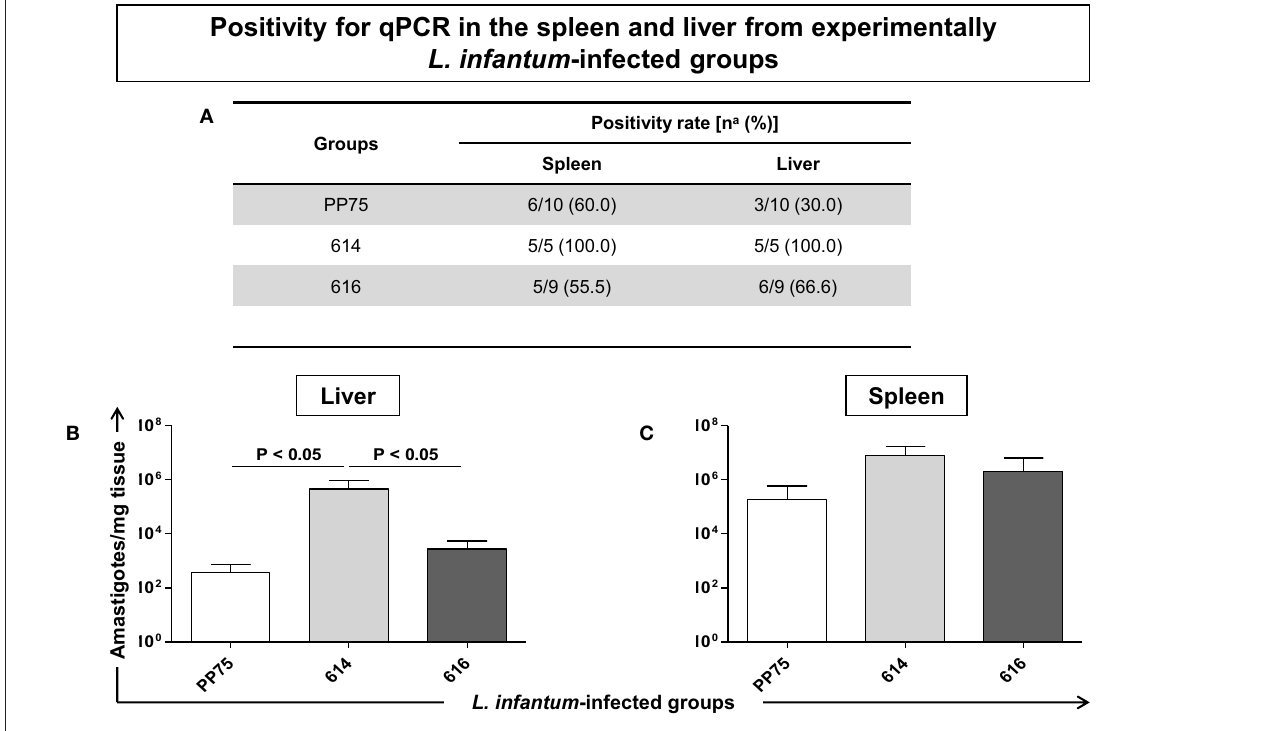
FIGURE 6 | Positivity for qPCR in the spleen and liver (A) from experimentally L. infantum -infected groups (reference strain: PP75; and wild strains: 614 and 616). (A) Number of positive hamsters in relation to total analyzed animals. Animals from 614 ( n = 5) group died before the end of the experiment, as demonstrated in the survival rate displayed in Figure 2 . The y-axis shows the number of amastigotes per milligram of tissue in the liver (B) and spleen (C) . The x-axis shows the L. infantum -infected groups (reference strain: PP75 and wild strains: 614 and 616). The significant difference ( P < 0.05) is indicated on the graph by connecting lines.